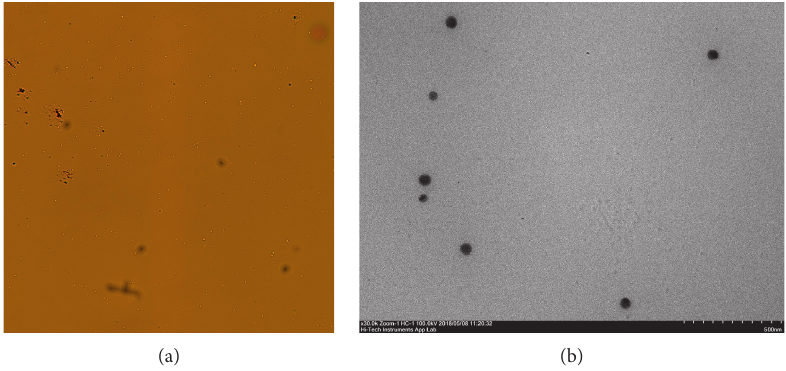
Figure 4: Droplet size and morphology of DFS-NE under polarized and TEM